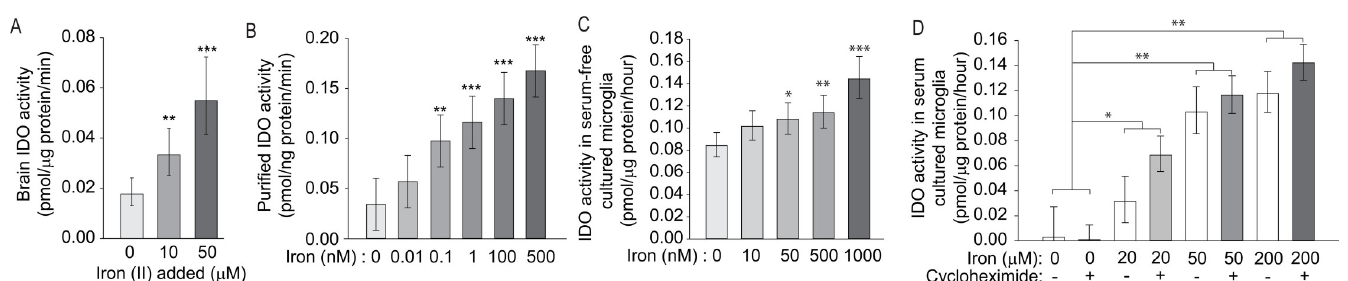
Fig 2. Nanomolar levels of iron activates IDO. The effect of iron on IDO activity was determined in brain extracts, purified protein, and the immortalized EOC20 mouse microglial cell line. A . Iron (II) ammonium sulfate increases IDO activity in protein extracts from 14-week-old WT mouse brains in a dose-dependent manner. n = 5. B . Iron (II) activates purified IDO. n = 3. C . Iron(II) added to cultured microglia in serum-free medium for 2 hours increased IDO activity. n = 3. D . Iron(II) was added to the medium of cultured microglia for 2 hours with and without addition of cycloheximide, and IDO activity was determined. IDO activity was significantly increased by iron but there was no effect of cycloheximide. n = 6. A, D . Data are shown as the mean ± 95% CI. B, C . Data are shown as the mean ± SE. � p < 0.05, �� p < 0.01, ��� p < 0.001. A-C. Asterisks represent comparisons to samples without iron addition.